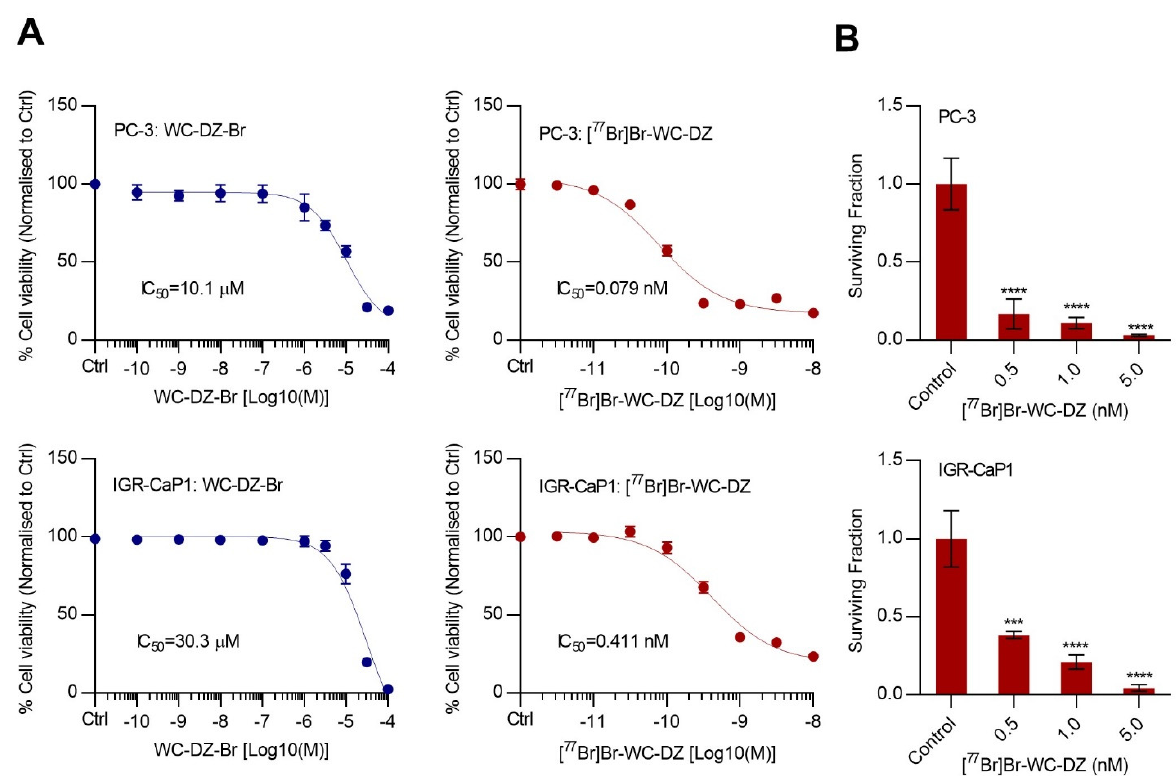
Figure 2. The [ 77 Br]Br-WC-DZ induces cytotoxicity and decreases the colony-forming ability of prostate cancer cell lines. ( A ), PC-3 and IGR -CaP1 cells were treated with increasing doses of WC- DZ-Br (10 − 10 to 10 − 4 M) or [ 77 Br]Br-WC-DZ (10 − 11.5 to 10 − 8 M) in biological replicates of five for 120 h. Cell viability was determined using an MTS assay. Graph represents a percentage (%) mean cell viability normalized to control ± SD. ( B ), the effect of [ 77 Br]Br-WC-DZ on prostate cancer cell survival. PC-3 and IGR-CaP1 cells were treated with [ 77 Br]Br-WC-DZ (0.5, 1, and 5 nM) in biological replicates of three for 3h, washed, and the ability of the cells to form colonies was assessed after 14 days in a clonogenic survival assay. *** p < 0.01 and **** p < 0.0001 compared to the control.